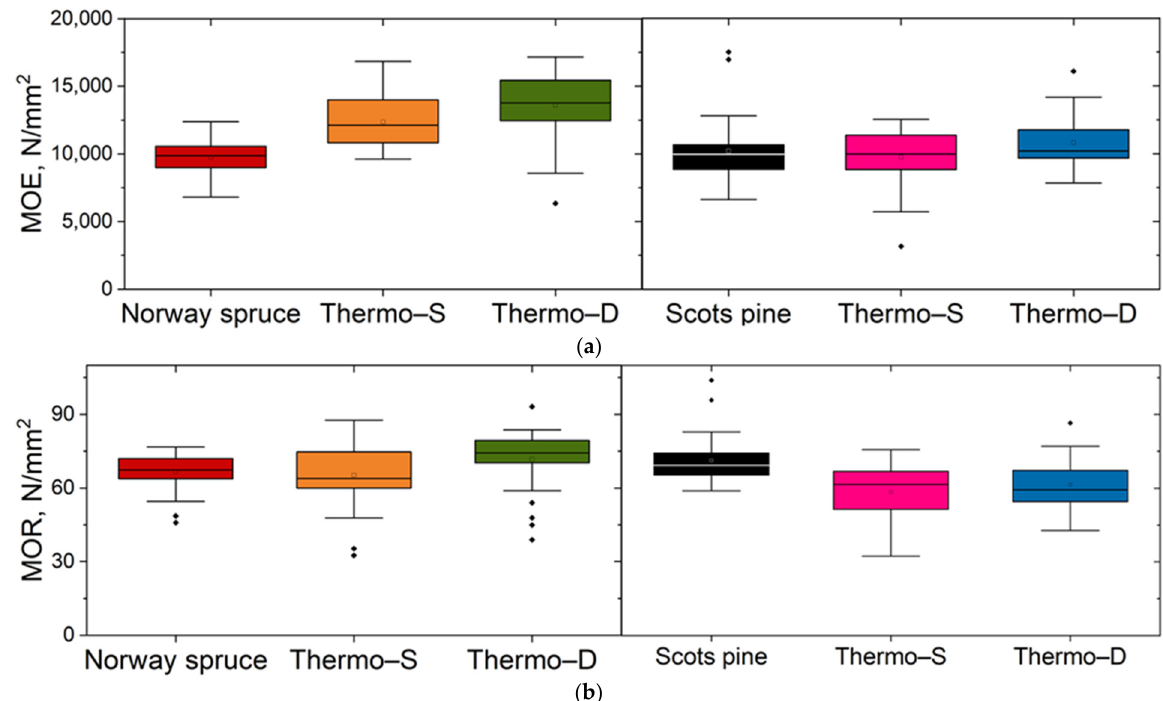
Figure 6. MOE ( a ) and MOR ( b ) measured for untreated and ThermoWood ® Norway spruce and Scots pine.